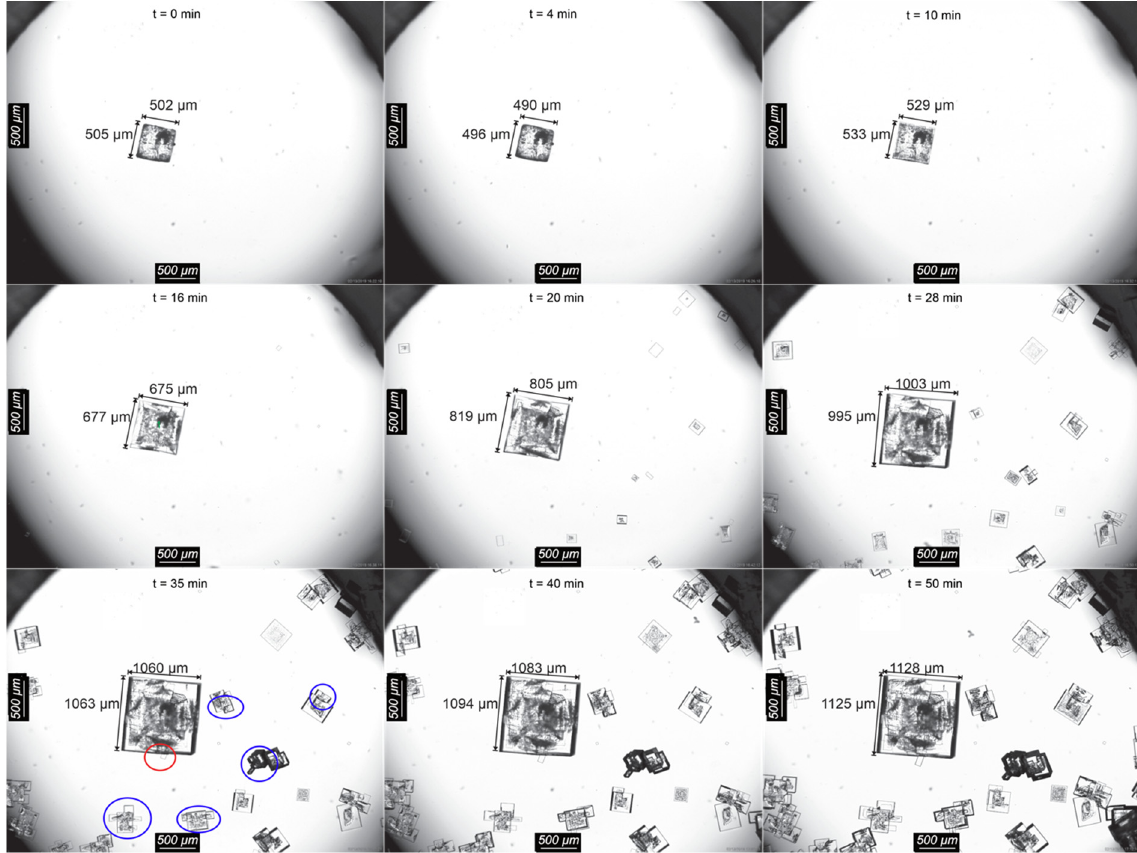
Figure 4. Optical photomicrographs along time of the NaCl–KCl–H 2 O droplet under evaporation seeded with NaCl. A crystal growing on the surface of the seed is surrounded with the red circle at the frame t = 35 min. Blue circled crystals indicate other possible epitaxially grown crystals.